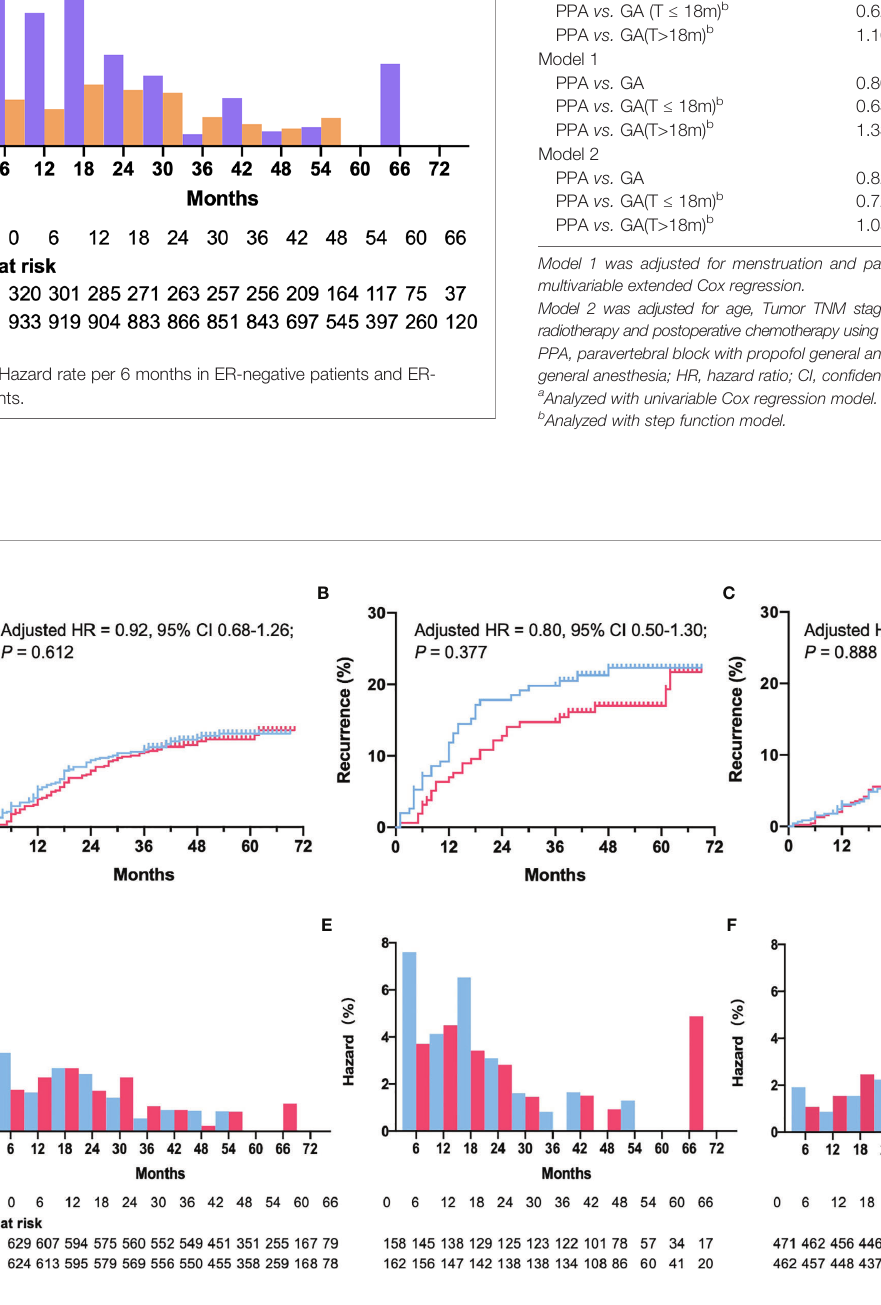
FIGURE 2 | Recurrence curve and hazard rate per 6 months among patients who were given PPA or GA. Recurrence curve in all patients (A) , ER-negative patients (B) , and ER-positive patients (C) . Hazard rate per 6 months in all patients (D) , ER-negative patients (E) , and ER-positive patients (F) . ER, estrogen receptor; PPA, paravertebral block with propofol general anesthesia; GA, fentanyl with sevo fl urane general anesthesia; HR, hazard ratio; CI, con fi dence interval. HR, 95% CI and P values were reported using adjusted multivariable Cox regression Model 1 adjusted for menstruation and pathology stage of tumor (binary).